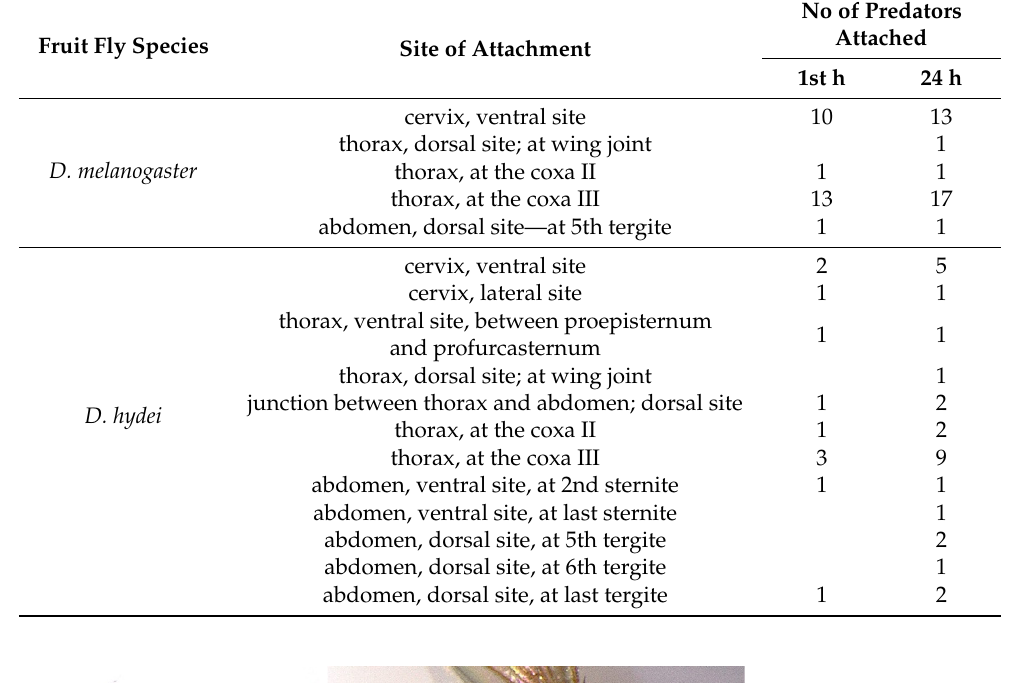
Table 2. Sites of Blattisocius mali attachment to the cervix, thorax, or abdomen of Drosophila melanogaster and D. hydei female fruit flies noted during 24 h observations. For the first hour of observation, only the final attachments (that ended up with drilling) are given.